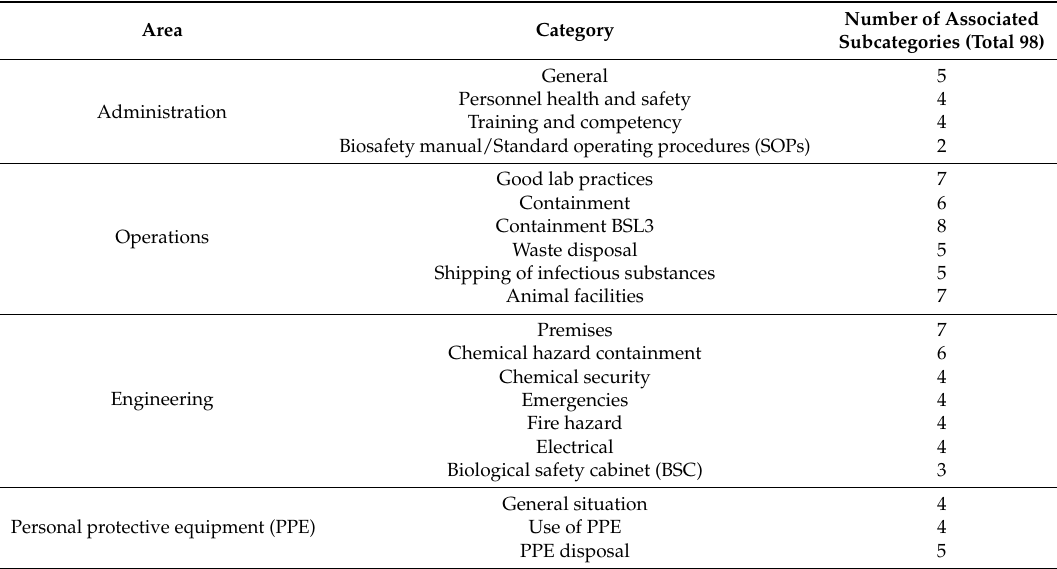
Table 1. Areas and categories covered by the safety and biosecurity module of the Laboratory Management Tool (LMT-S